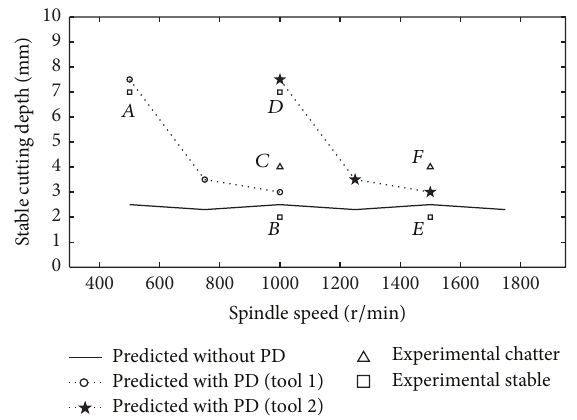
Figure 10: Stability limits generated from computations and exper-